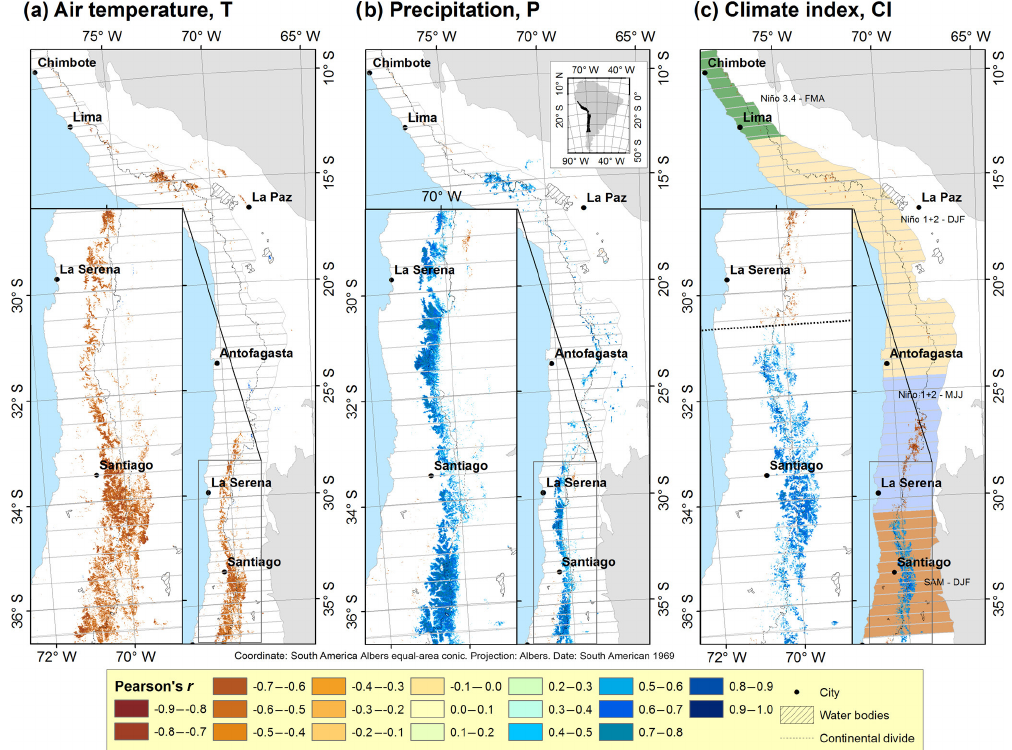
Figure 8. Map of Pearson’s correlation coefficient ( r ) between 2000 and 2016 annual SP and (a) mean annual temperature, (b) annual total precipitation, and (c) the best climate index and the 3-month time window that had strongest correlations with SP in each region. Time windows give the range of months over which the climate index was averaged, expressed by first letter of each month. DJF is December, January, February; FMA is February, March, April; MJJ is May, June,